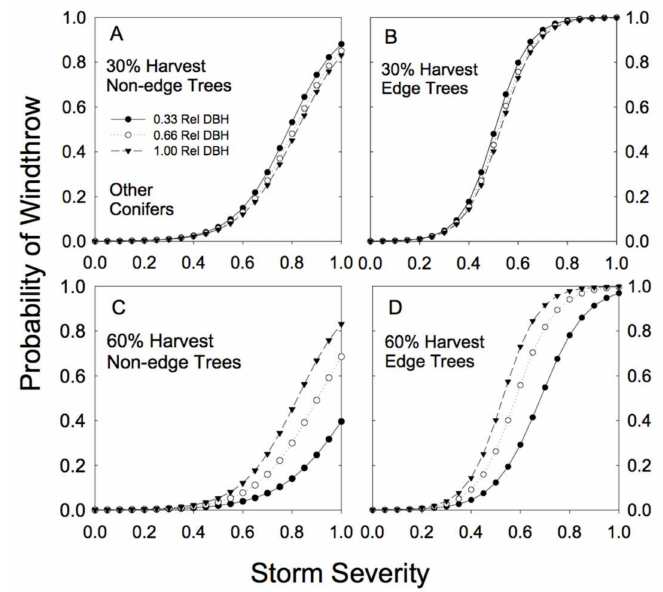
Figure 6. Predicted susceptibility to windthrow as a function of relative tree size and proximity to a forest edge for other conifer species. The predictions were generated from Model 4a, using the parameters reported in Table 2, for two different levels of prior harvest (30% and 60% basal area removal) and for 3 different relative tree sizes (0.33, 0.66, and 1.00 relative DBH). ( A ) For non-edge trees in a plot with a 30% harvest; ( B ) edge trees in a plot with a 30% harvest; ( C ) non-edge trees in a plot with a 60% harvest; ( D ) edge trees in a plot with a 60% harvest.